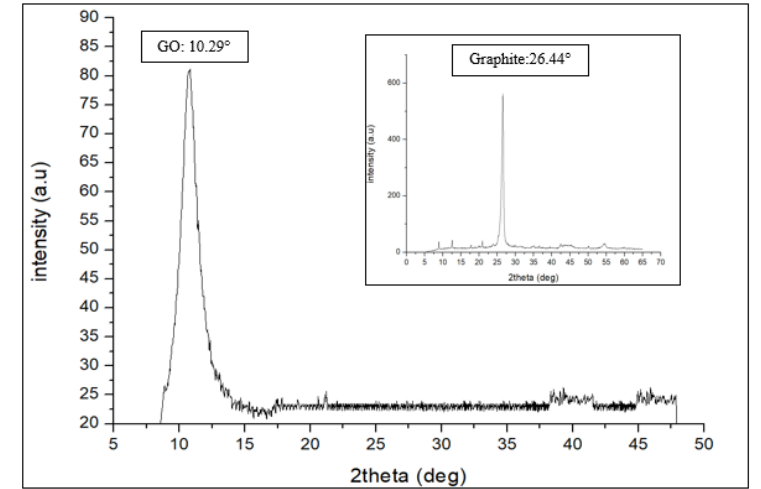
Fig. 3. XRD peak for graphite and